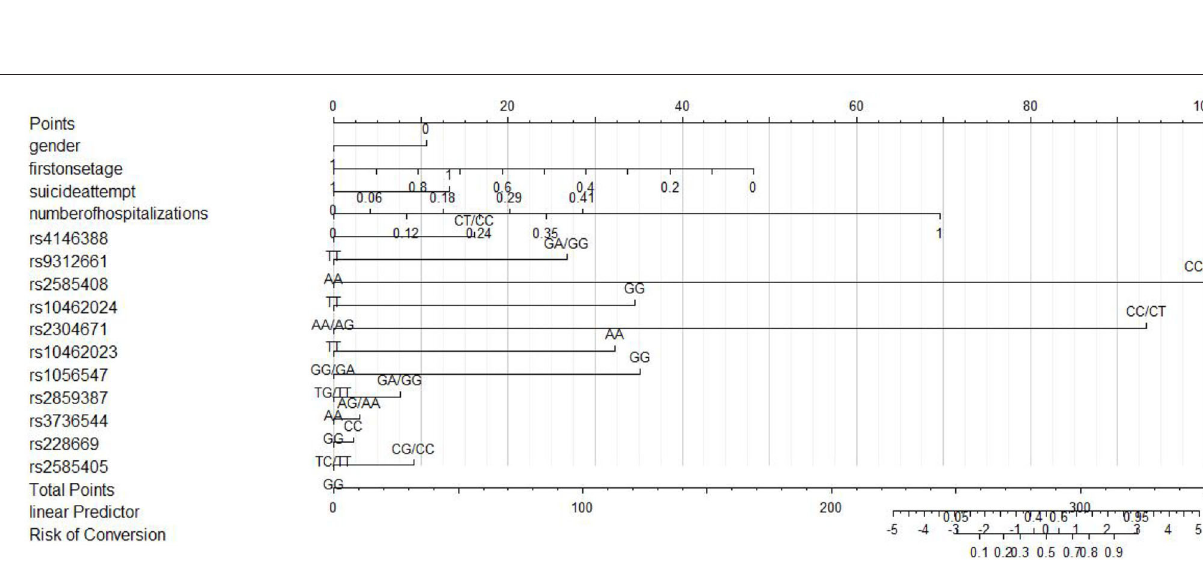
FIGURE 5 | The five cross-validations were used as internal validation for model2.